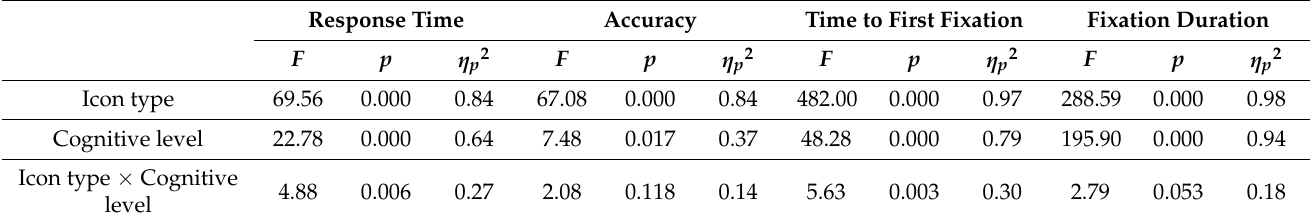
Table 4. ANOVA results for icon type and cognitive